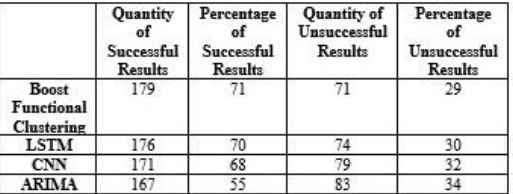
Table 6: 2007 Ounce Gold Application Test